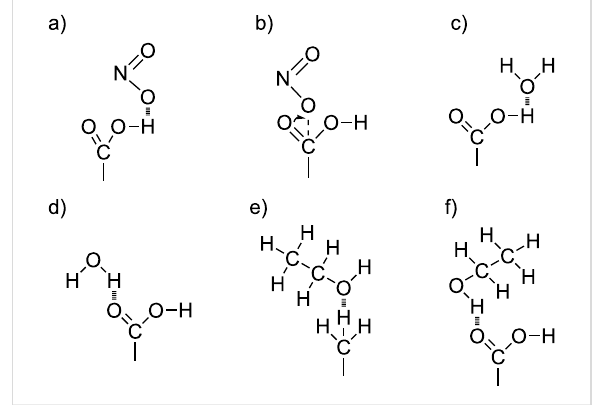
Figure 6: Electrostatic interactions pathways between –COOH func- tional groups and nitrogen dioxide (a, b), water (c, d) and ethanol (e, f).